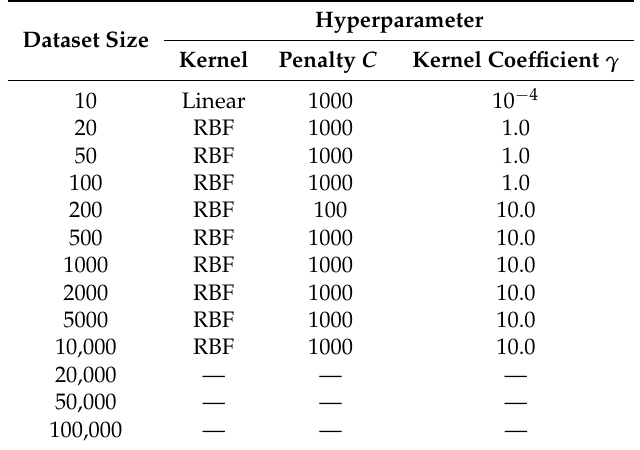
Table A2. Hyperparameters for SVM yielding the highest validation accuracy across dataset